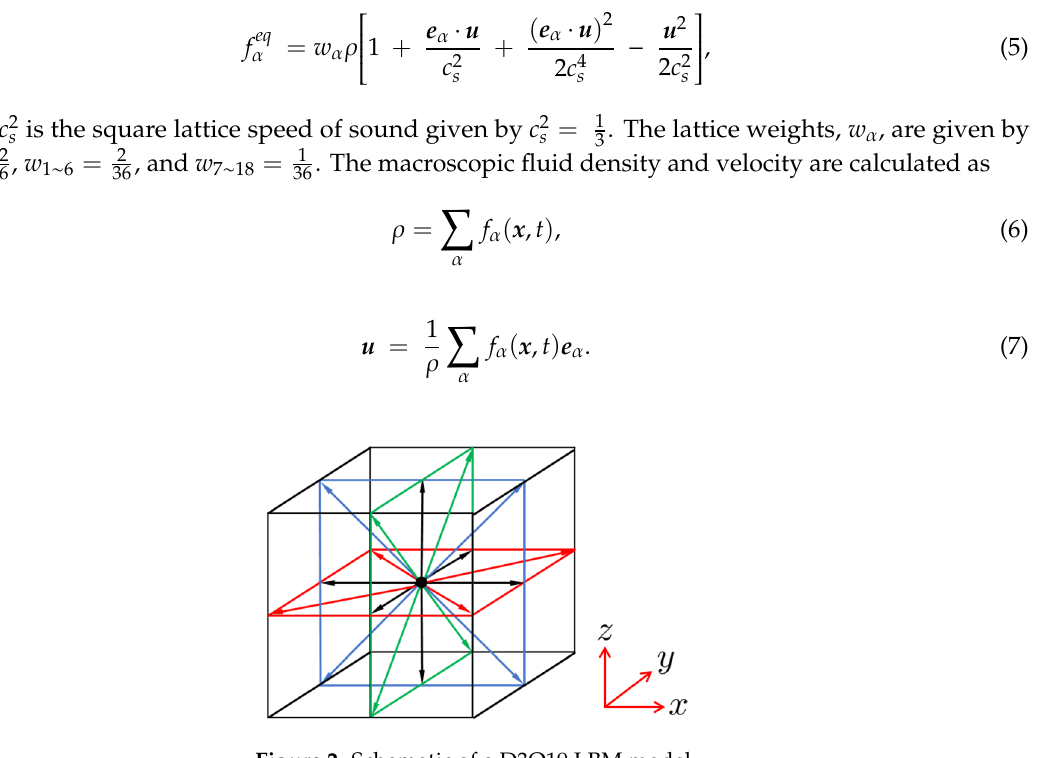
Figure 2. Schematic of a D3Q19 LBM model.